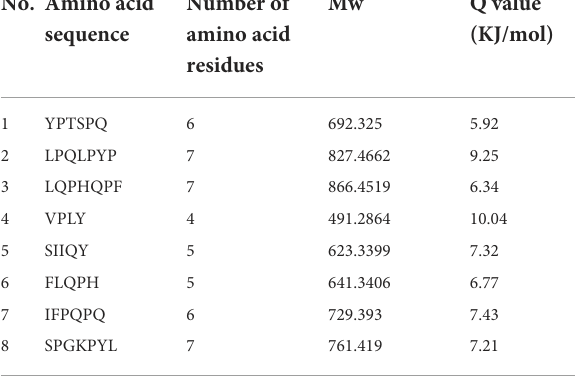
TABLE 5 Result of peptides sequence of WGH-Alc20M determined by HPLC-MS/MS.